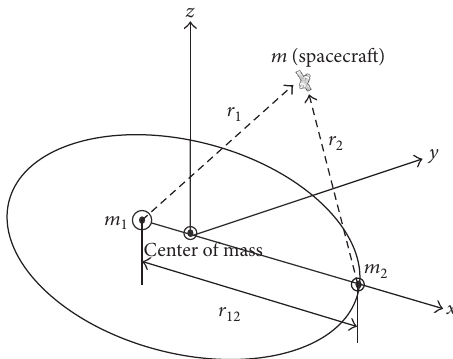
Figure 1: Diagram of the circular restricted three-body problem in o - xyz